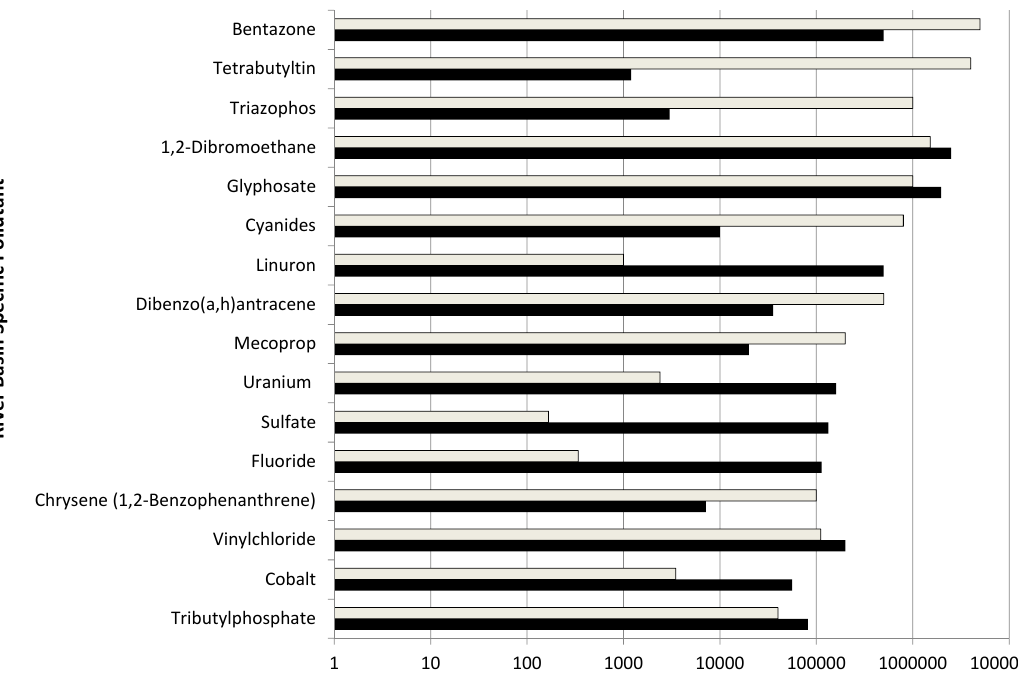
Divergence between highest and lowest EQS for the same substance (%) Figure 4. Divergence (in %) between minimum values and maximum values of EQSs for RBSPs reported by different MS. 16 substances are shown exemplary. Medium of measurement for the substances = water. Grey bars = values reported by Arle et al. , 2012 [22], Black bars = values reported by Irmer et al. , 2014 [23]. Under the WFD, EQSs for RBSPs are derived according to fixed rules which should eliminate flexibility in the determination of standard values. Similar to the quality standards for substances under the chemical status classification, the EQSs for RBSPs should show identical values.